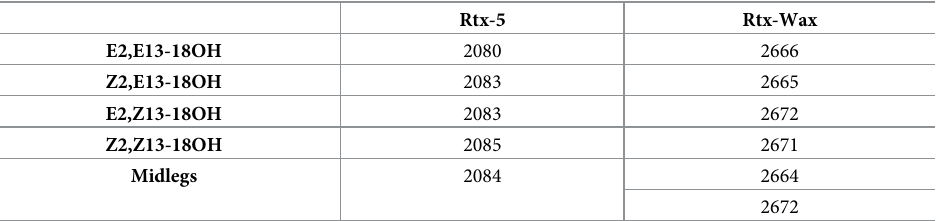
Table 3. Kovats indices for synthetic and natural 2,13-octadecadienol diastereoisomers in columns with different